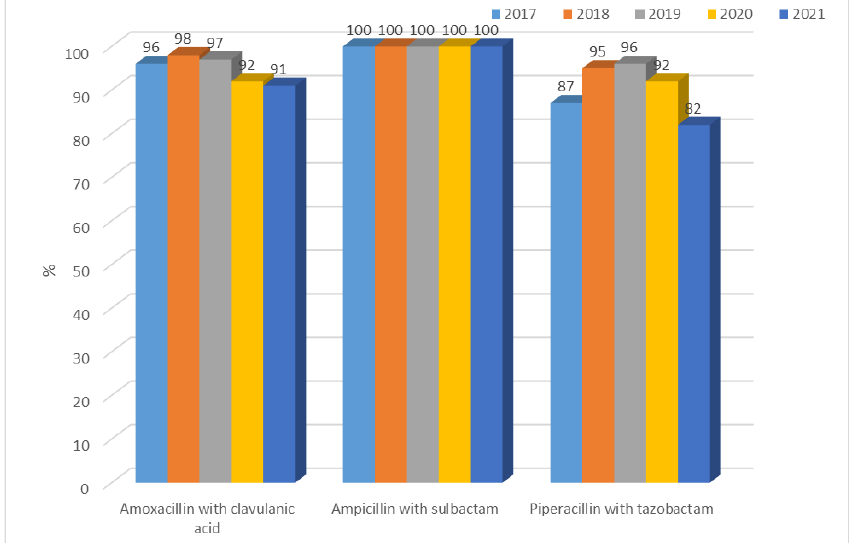
Figure 14. Percentage of K. pneumoniae ESBL(+) strains resistant to penicillins with inhibitors. There are significant differences between the resistance of K. pneumoniae ESBL(−) strains in year-to-year analysis for each cephalosporin ( p < 0.001). Until 2019, the percent- age of K. pneumoniae ESBL(−) strains resistant to second-generation cephalosporins was at a consistently low level, ranging from 5% (n = 11) to 10% (n = 22). In the last two years, this resistance increased to 83% (n = 140, p < 0.001). A similar increase also occurred for E. coli ESBL(−). Among the third- and fourth-generation cephalosporins, the percentage of resistant strains that did not produce β-lactamases was relatively low, ranging from 1% to 14%, but this has gradually increased between 2020 and 2021 (Figure 15), comparing 2019 with 2020 and 2021 differences as significant for cefuroxime (2020 and 2021 p < 0.001), ceftazidime and cefotaxime (2020 p < 0.01, 2021 p < 0.001), and cefepime (2020 p < 0.05, 2021 p < 0.001). K. pneumoniae ESBL(+) strains consistently demonstrated very high resistance to second-, third-, and fourth-generation cephalosporins, ranging from 95% to 100% (Figure